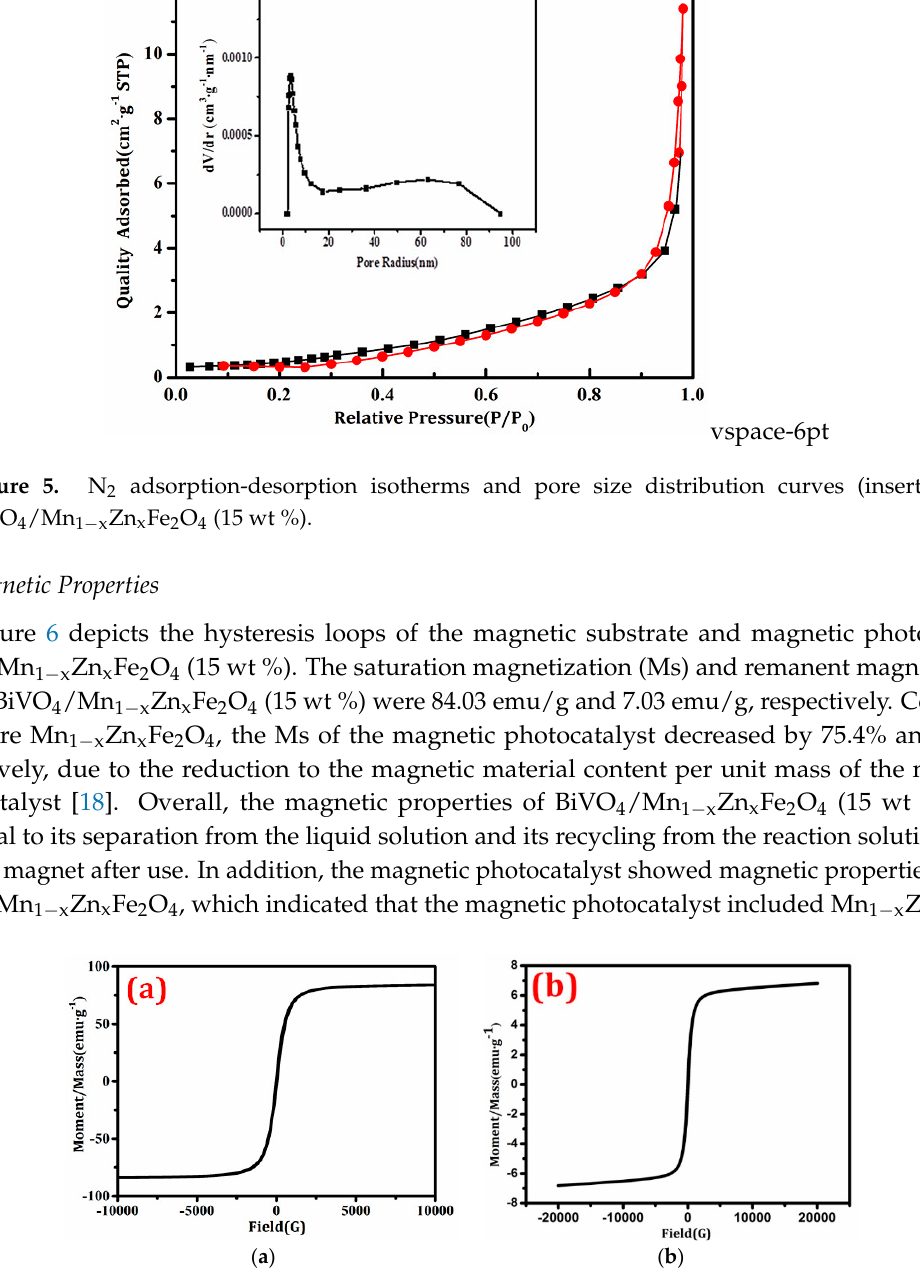
Figure 6. Hysteresis loops of ( a ) Mn 1 − x Zn x Fe 2 O 4 and ( b ) BiVO 4 /Mn 1 − x Zn x Fe 2 O 4 (15 wt %).